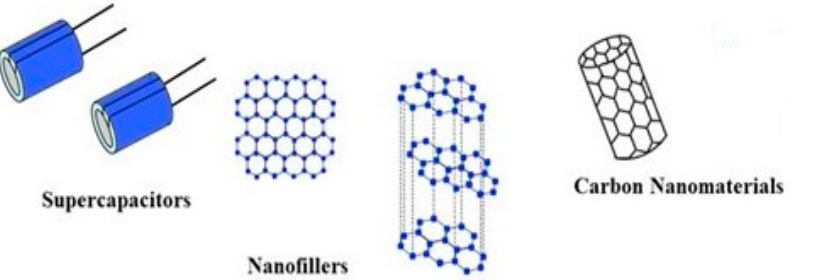
Figure 4. Diverse roles of PHAs as biocompatible biomaterials and as components in medical devices and varied medical applications.